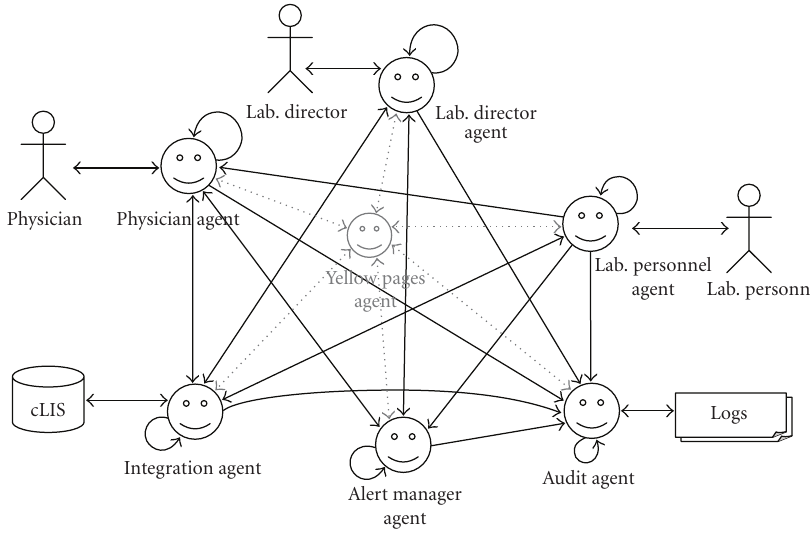
Figure 2: MediMAS overview.